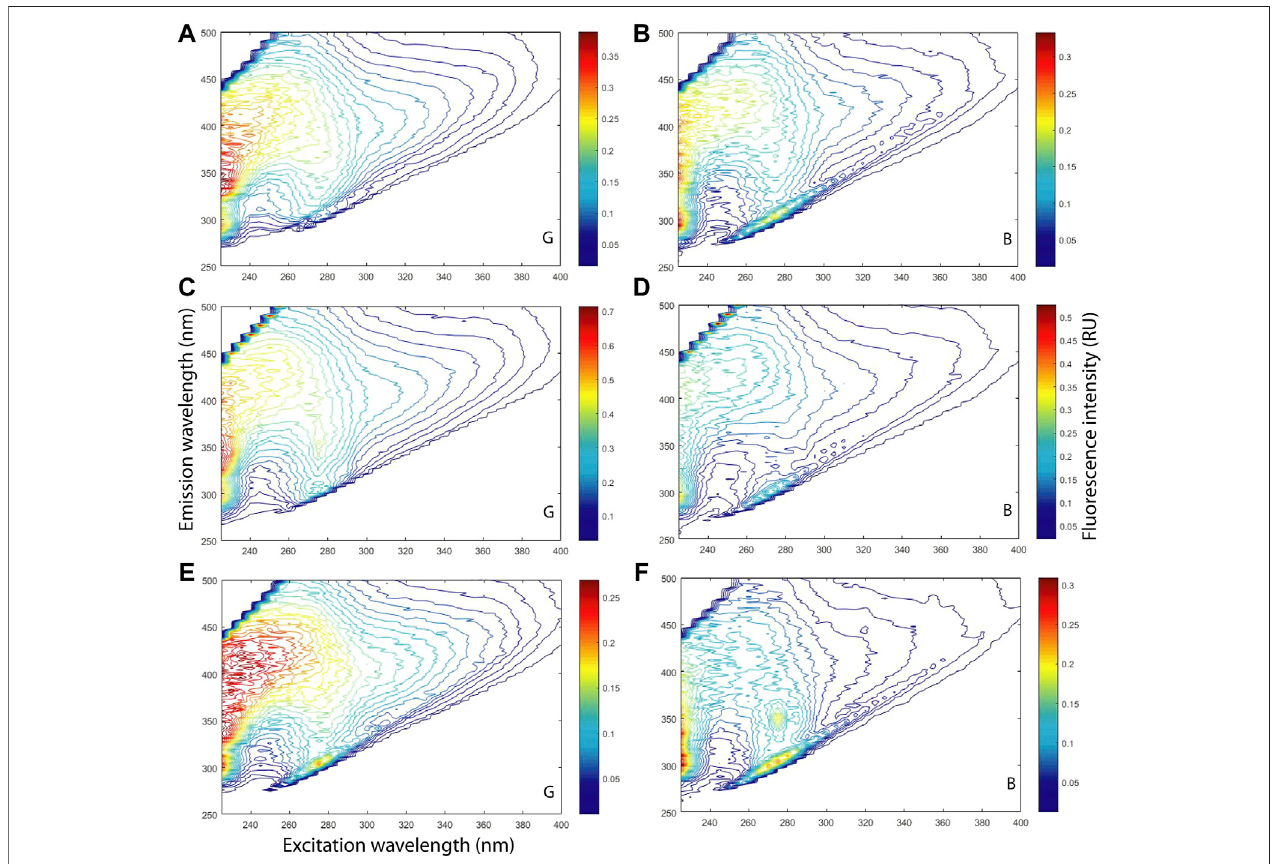
FIGURE2| Three-dimensionalEEMmeasurementofDOMusingmonthly fl uorescencedatainthepre-monsoon(April): (A) -Gand (B) -B;monsoon(August): (C) -G and (D) -B;andpost-monsoon(December): (E) -Gand (F) -BintheGanges (G) andBrahmaputrarivers. (B) .Identi fi ed fl uorophoresintheGangesRiver:PeakA(Ex/Em=